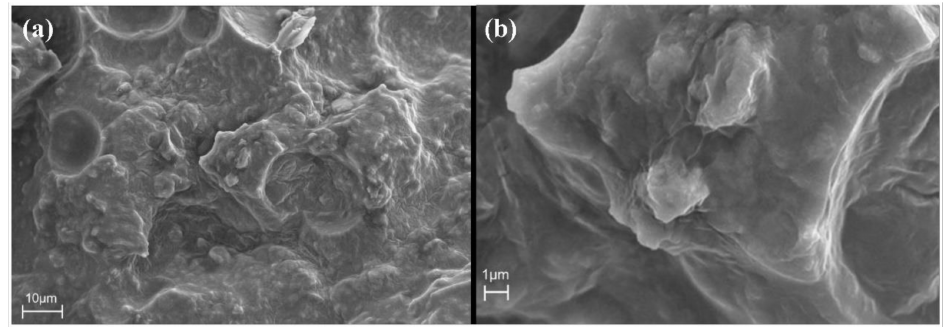
Figure 4. SEM images of cured resin system (( a ). low magnification; ( b ). high